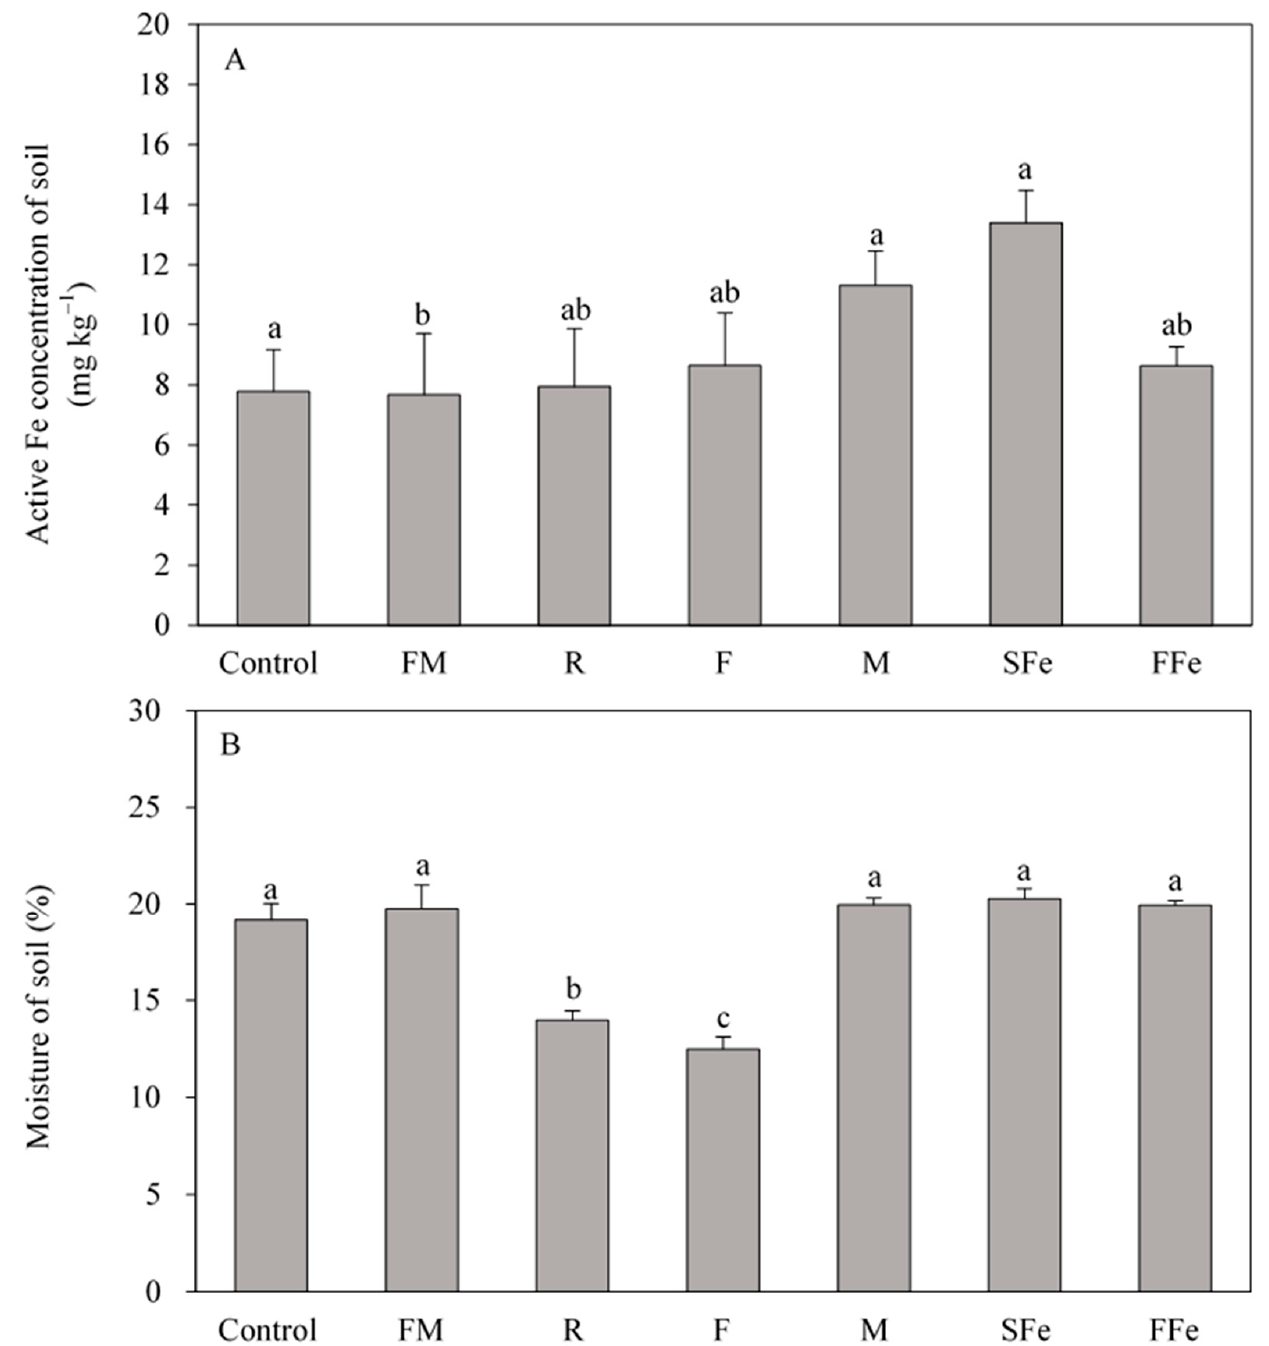
Figure 4. Active Fe concentration ( A ) and moisture of soil ( B ) in 0 − 40 cm depth of HG-QA grown in different practices. HG-QA: “Huangguan” pear grafted onto quince A. Control: ridging with landscape fabric mulching and without other treatments; FM: flattening with landscape fabric mulching, R: ridging without landscape fabric mulching; F: flattening without landscape fabric mulching; M: Manure application; SFe: Fe application in soil; FFe: Foliar Fe application. The different letters mean statistical differences between treatments, p < 0.05 (Benjamini–Hochberg correction). The soil moisture data and post hoc test results are shown in Figure 4B. The soil moisture levels under R and F were 14.0% and 13.5%, respectively, which were significantly lower than that under the control (19.1%). The lowest soil moisture level was observed under F. The soil moisture levels under FM, M, SFe, and FFe were the same as that under the control and ranged from 19.73 to